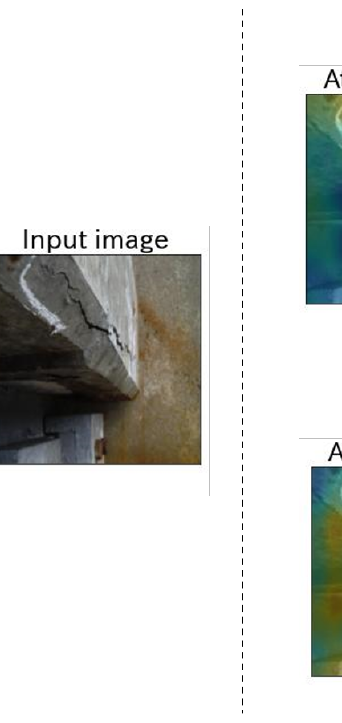
Figure 6. Estimated example at the degradation degree A for the distress type of concrete